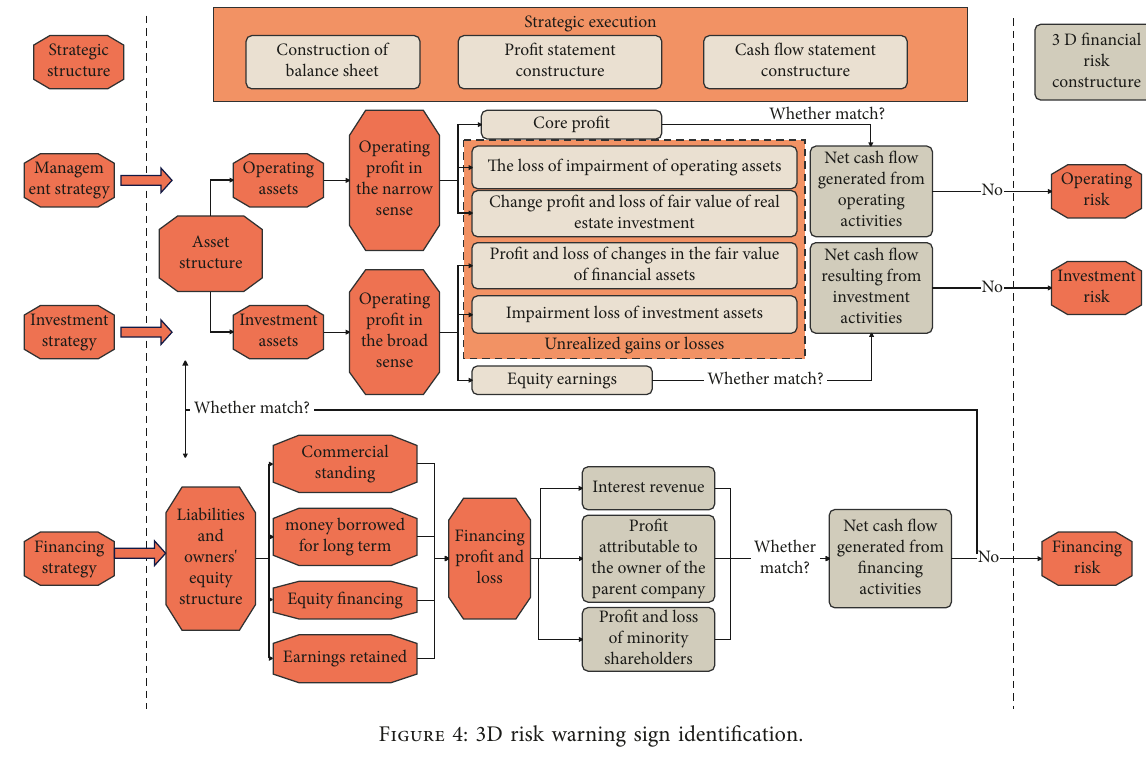
Figure 4: 3D risk warning sign identification.